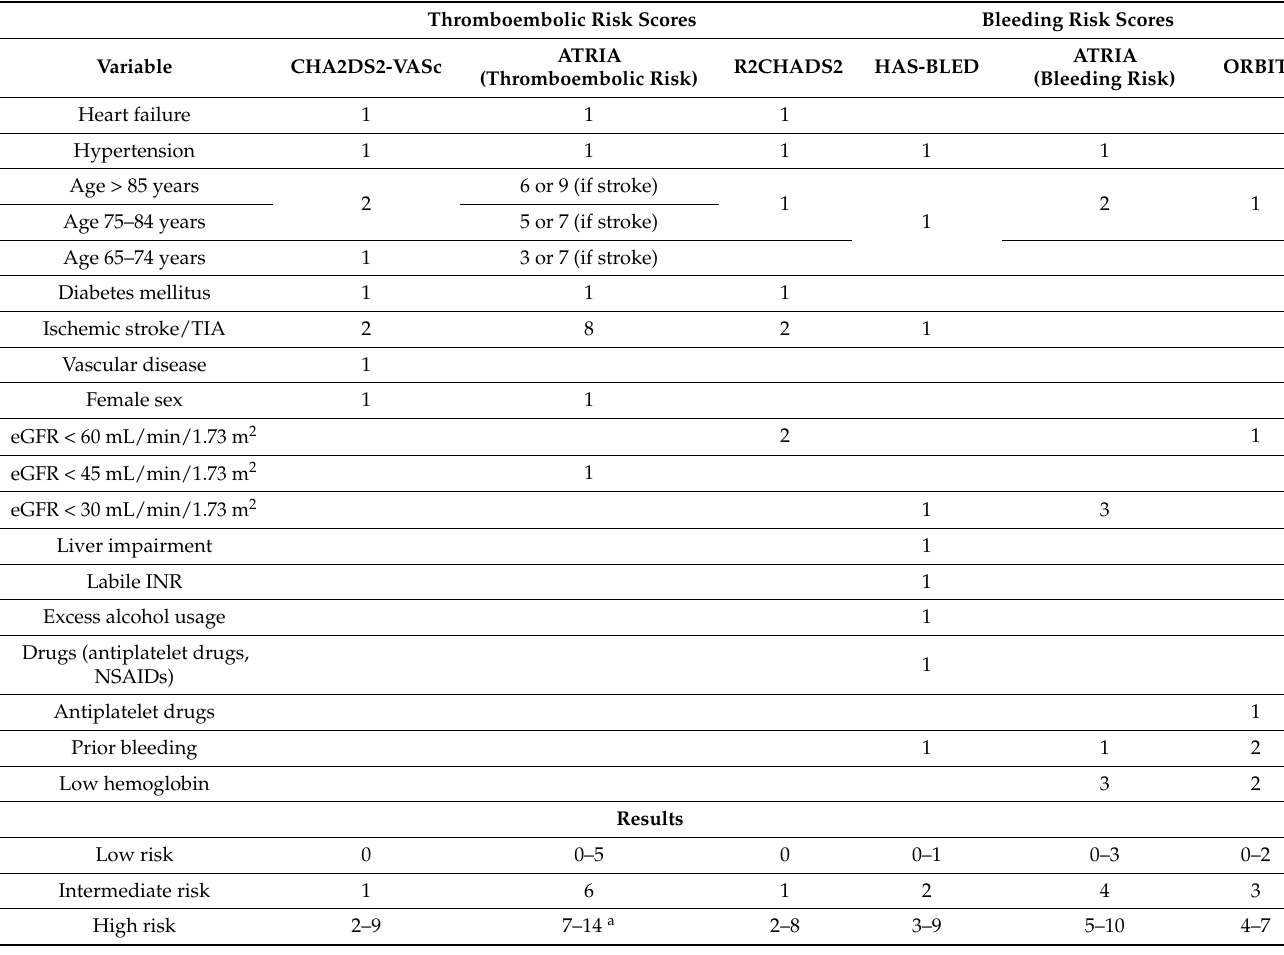
Table 1. Thromboembolic and bleeding risk scores. a All patients were given a value of 0 for the proteinuria risk factor in the present study. Abbreviations: eGFR, estimated glomerular filtration rate; INR, international normalized ratio; NSAIDs, nonsteroidal anti-inflammatory drugs; TIA, transient ischemic